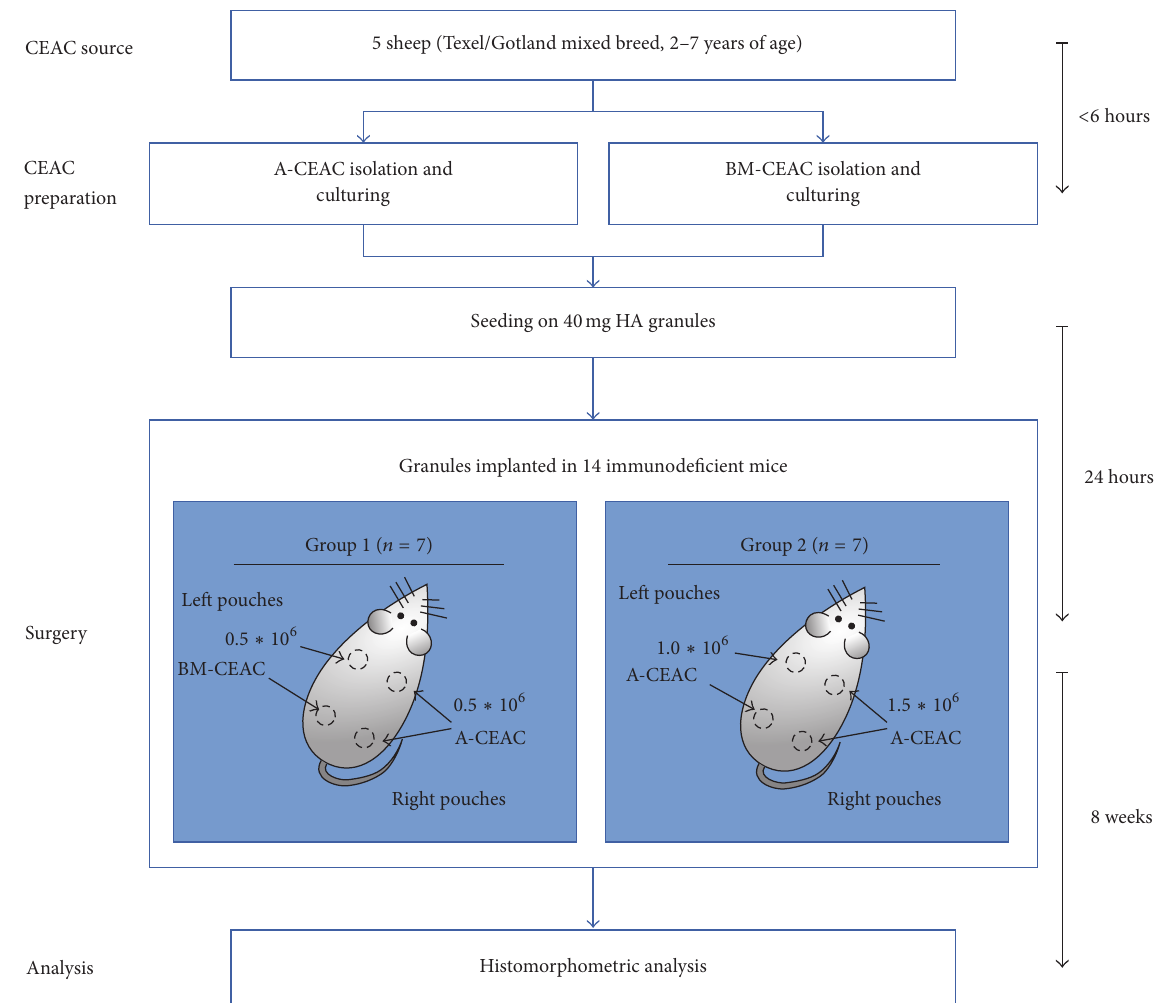
Figure 1: Study design. CEAC from adipose tissue (A-CEAC) and bone marrow (BM-CEAC) was isolated from 5 female sheep, expanded in vitro, and seeded onto HA prior to subcutaneous implantation in immunodeficient mice. After 8 weeks, implants were harvested and bone volume versus total tissue volume was assessed by histomorphometry. Each mouse received four implants as previously described [19].